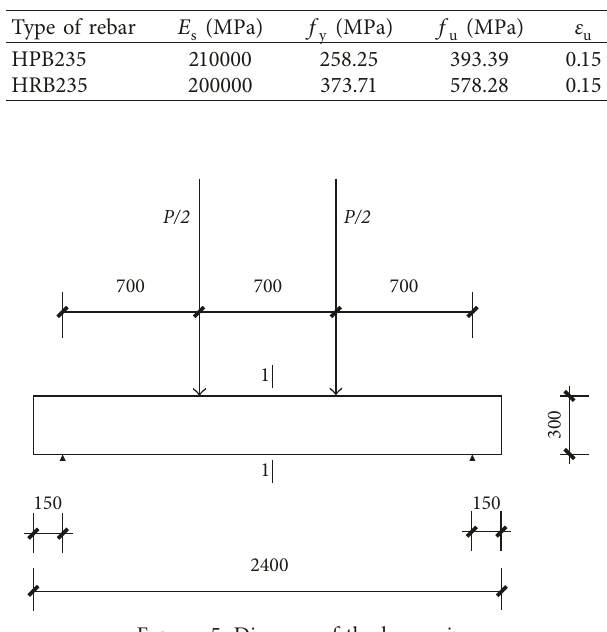
Figure 5: Diagram of the beam size.